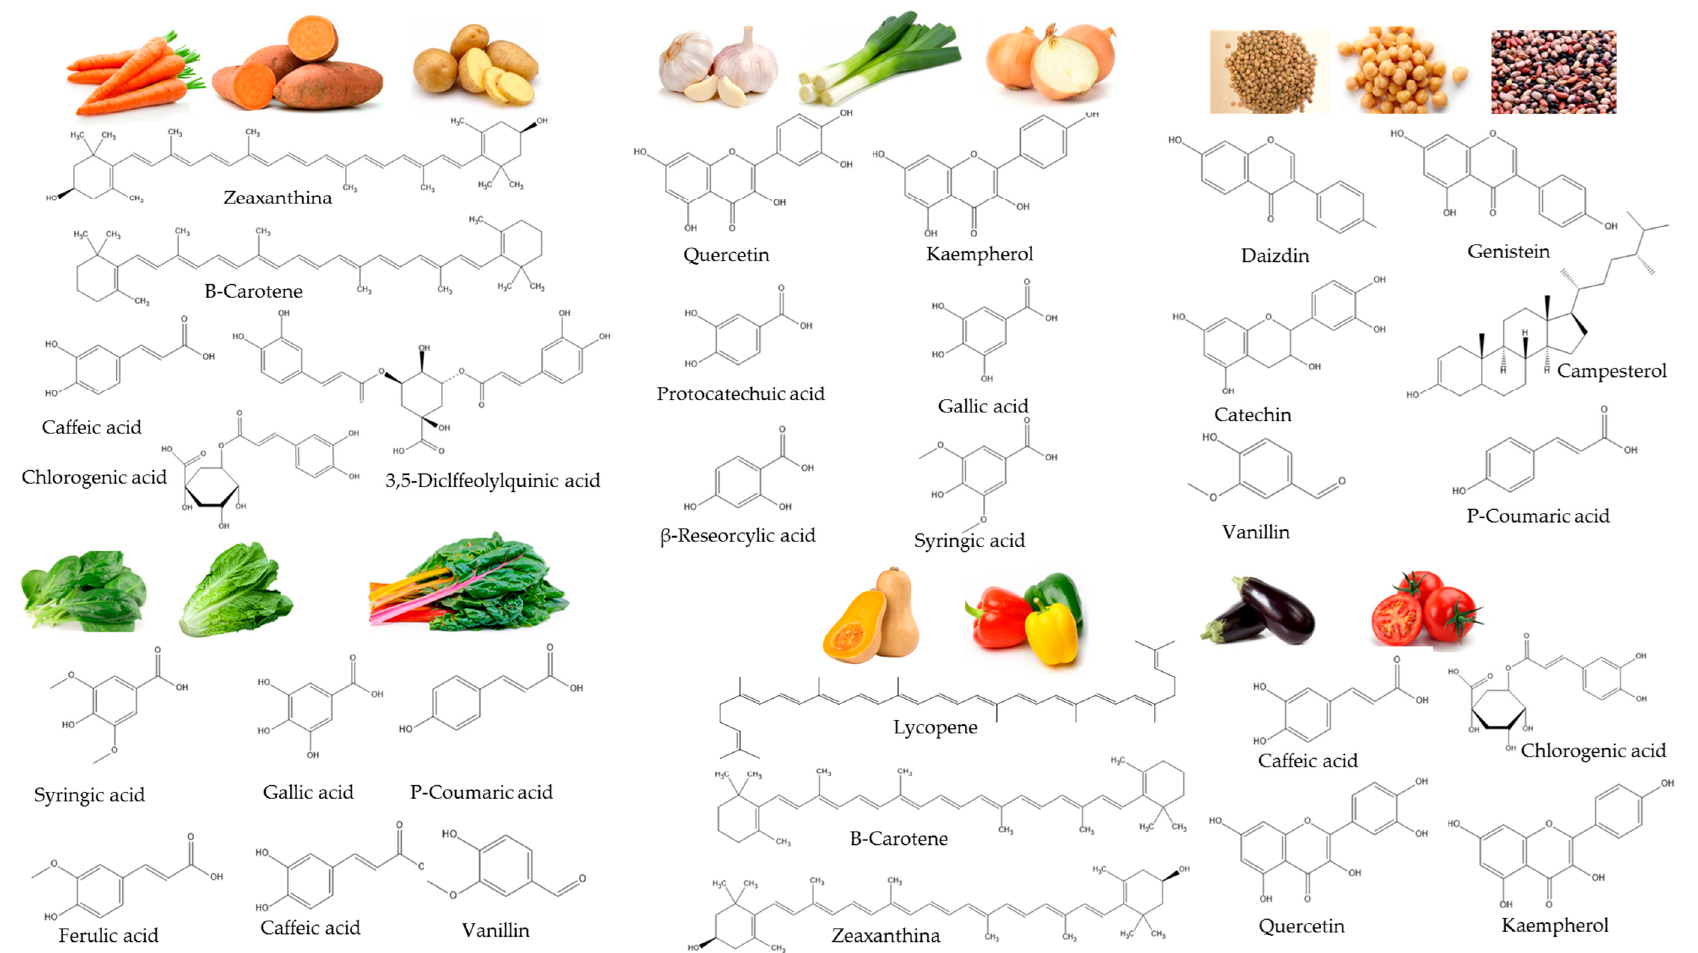
Figure 1. Main bioactive compounds present in the ingredients frequently used in the preparation of vegetable soups.